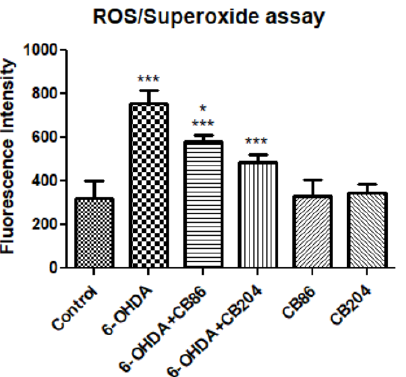
Figure 5. ROS/Superoxide assay: Release of ROS/superoxide was induced by the exposure of PC12 cells to 80 µM 6-OHDA for 24 h. Simultaneously, the PC12 cells were treated with or with CB86 or CB204 (25 µM each) for 24 h. Results are expressed by mean ± SD ( n = 8 replicates in each group). ANOVA followed by Bonferroni’s post -hoc test was performed, F (5, 42) = 75.18, p < 0.001. *** p < 0.001 vs. control, and * p < 0.05 compared to 6-OHDA+CB204.